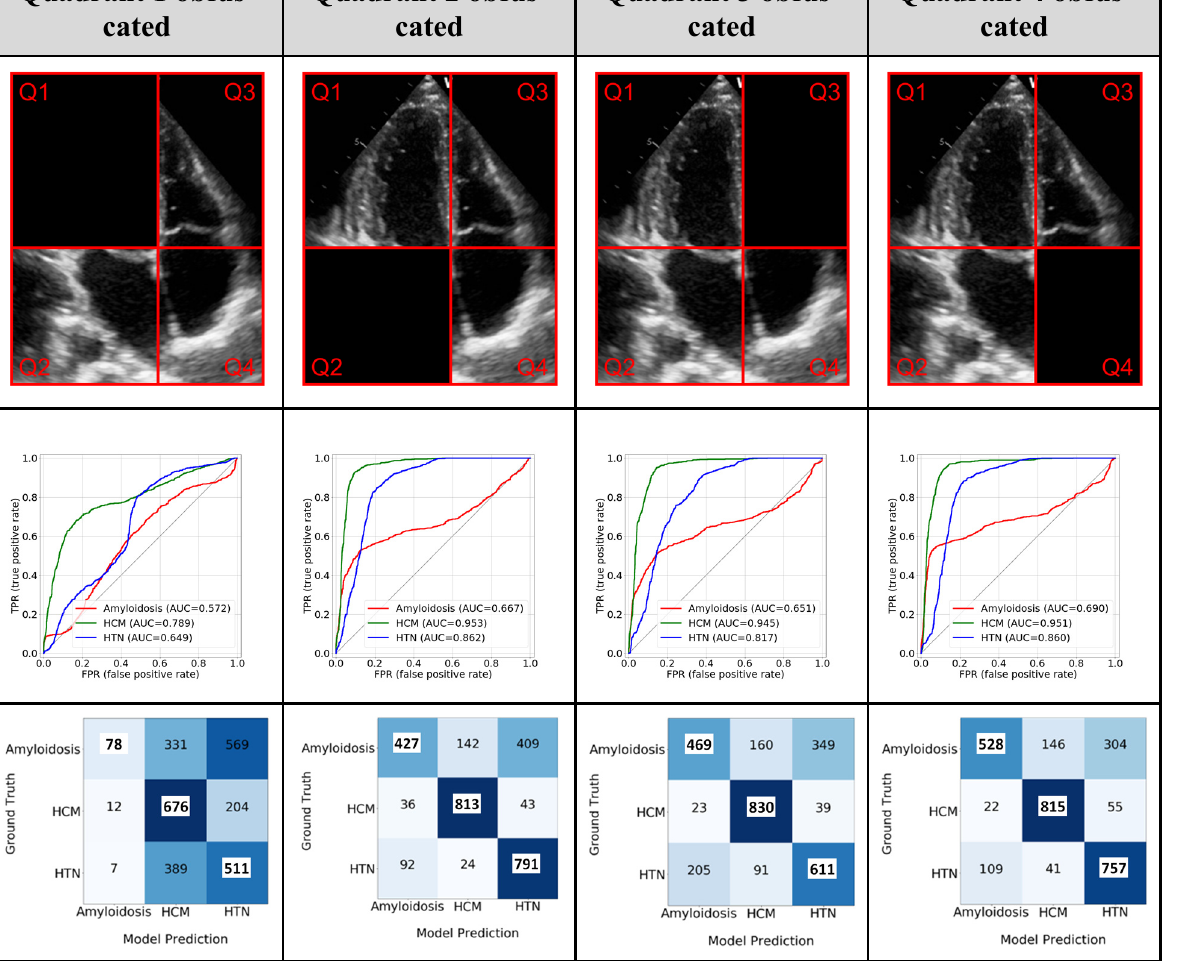
Figure 6. Ablation study—Removing image information. The top row shows the different quadrants ( Q1 , Q2 , Q3 , and Q4 ) representing different parts of the image information that was removed. The second row shows the class-wise ROC plot and the third row shows the confusion matrix using partial images. ‘Others’ category is referred to as ‘HTN’.